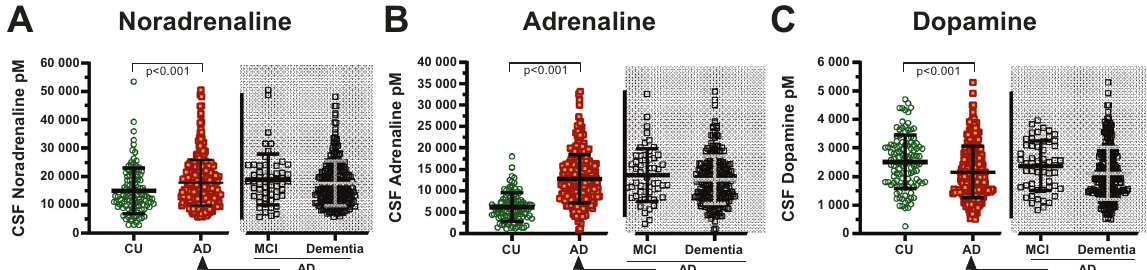
Fig. 1 CSF catecholamines and AD clinical presentation. CSF catecholamines in patients with a clinical Alzheimer ’ s disease presentation. Clinical AD patients at the MCI and dementia stage had similar concentrations of A gray area CSF noradrenaline, B gray area adrenaline, and C gray area dopamine (all p > 0.05). These were therefore analyzed as one AD group shown in red color. A All AD patients had higher concentrations of noradrenaline compared to the CU. B Likewise, all AD patients had higher concentrations of CSF adrenaline than the CU. In contrast, C CSF dopamine concentrations were lower among all AD patients than the CU. The larger and smaller lines represent mean and standard deviation respectively, while p -values were obtained by t -test. AD Alzheimer ’ s disease, CSF cerebrospinal fl uid, CU cognitively unimpaired, MCI mild cognitive impairment, pM picomolar. Table 2. Characteristics A − T − cognitively unimpaired and A + T + patients.